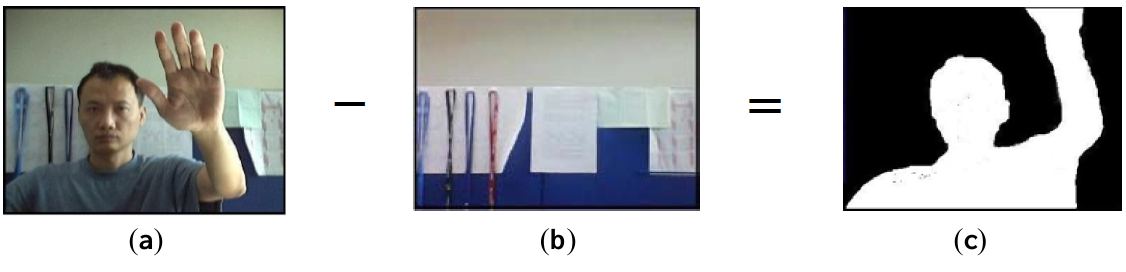
Figure 1. Moving object detection. ( a ) Front image; ( b ) Background image; ( c ) Moving